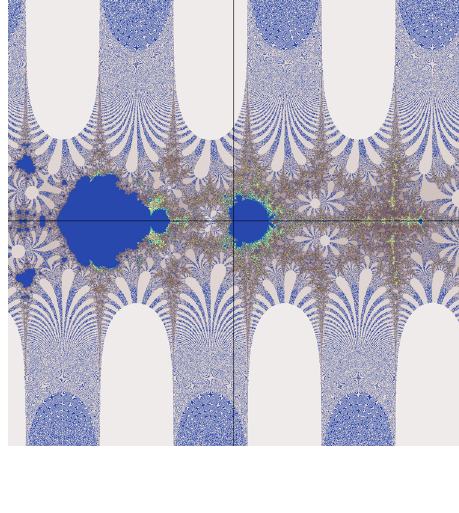
Figure 8: The slice PL of f